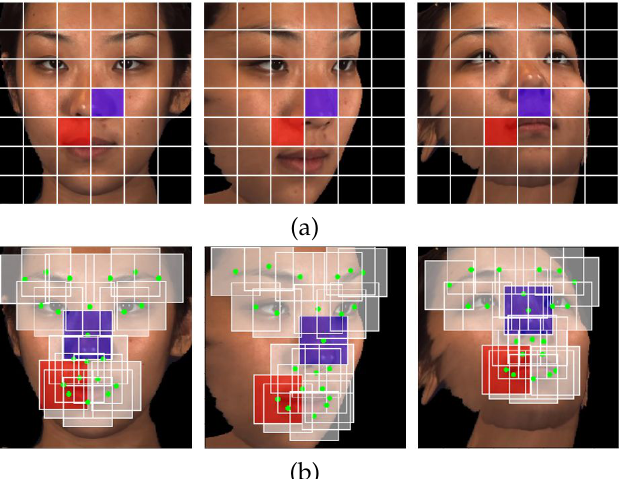
Figure 5. In the presence of pose, the uniform grid ( a ) suffers from a lack of correspondences (red and blue rectangles) due to displacement and occlusion. To minimize this lack of correspondence, facial landmarks are used to define a sparse set of patches ( b